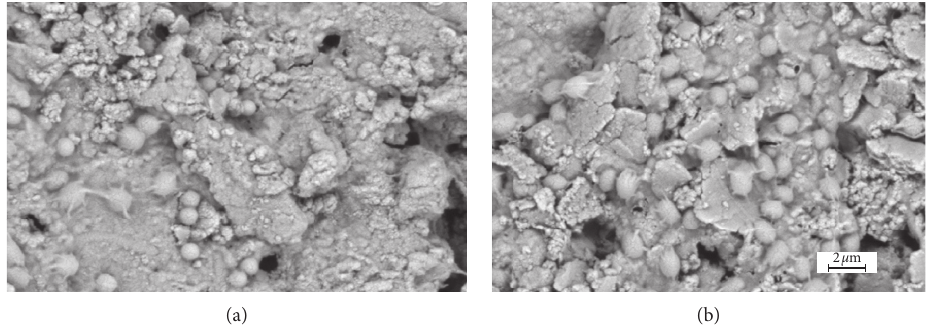
Figure 1: Biofilm formation by Enterococcus faecalis in the intracanal after (a) 4 th week and (b) 6 th week of culture. Photo was captured by SEM microscopy with gold staining of the surface of canals for biofilm